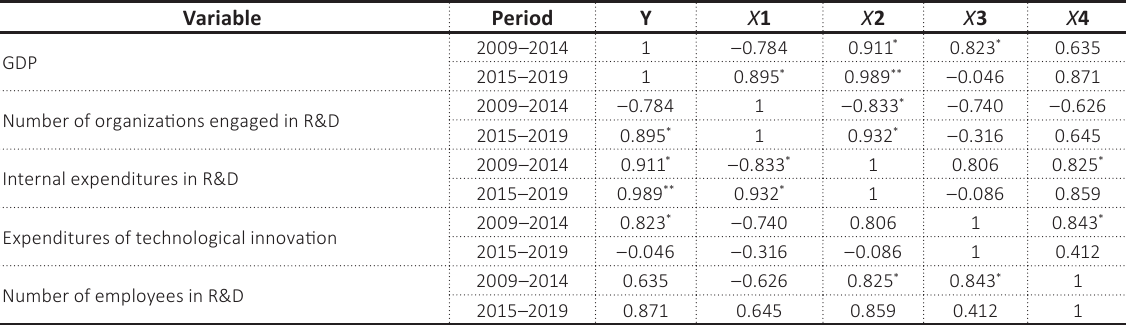
Table 6. Pearson correlation matrix of the variables